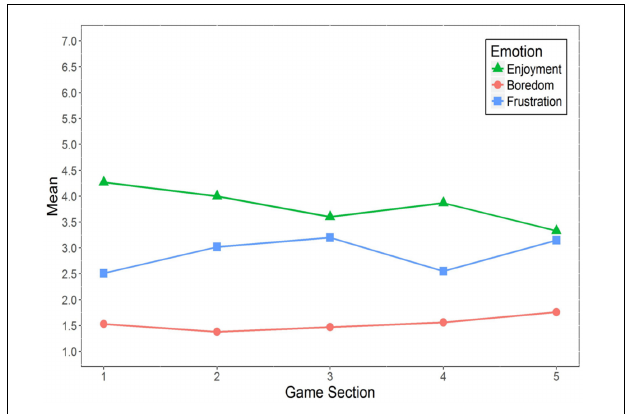
FIGURE 6 | Changes in the activity features of bodily expression during playing Cure Runners . Means multiplied by 100. n =